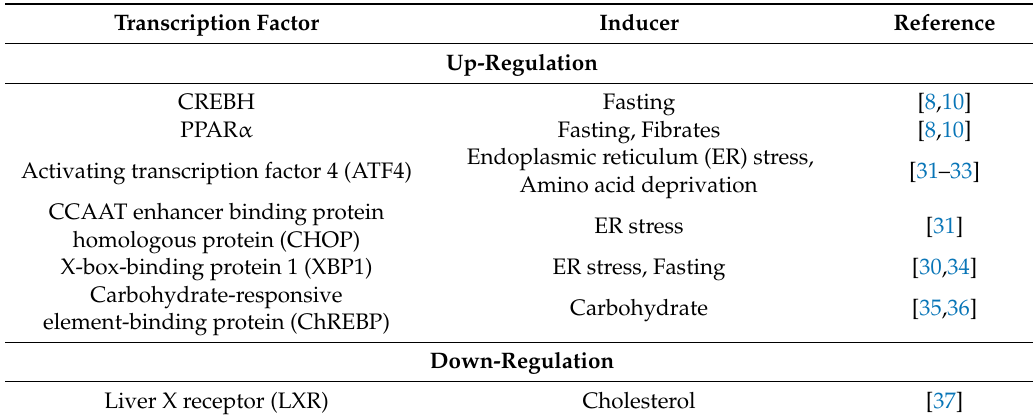
Table 2. The list of transcription factors regulating Fgf21